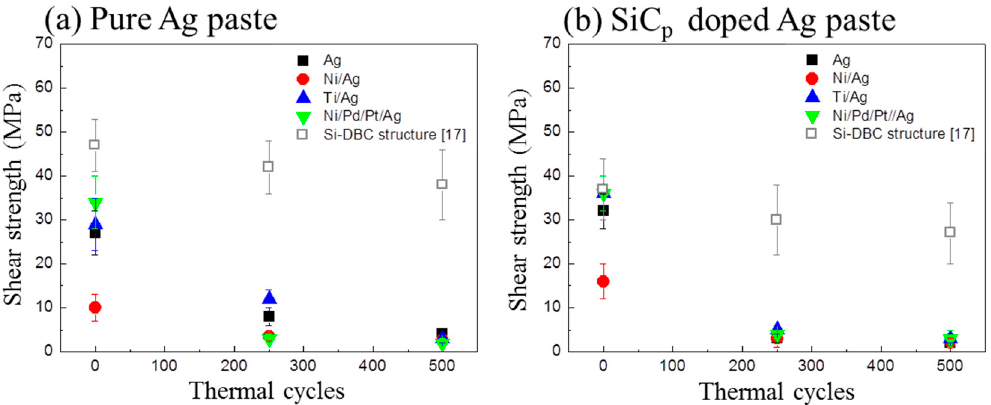
Figure 8. Evolution of the die shear strength of ( a ) pure Ag paste and ( b ) SiC p -doped Ag paste on various substrates, the former die-shear results of Si-DBC joints are listed as reference [17].